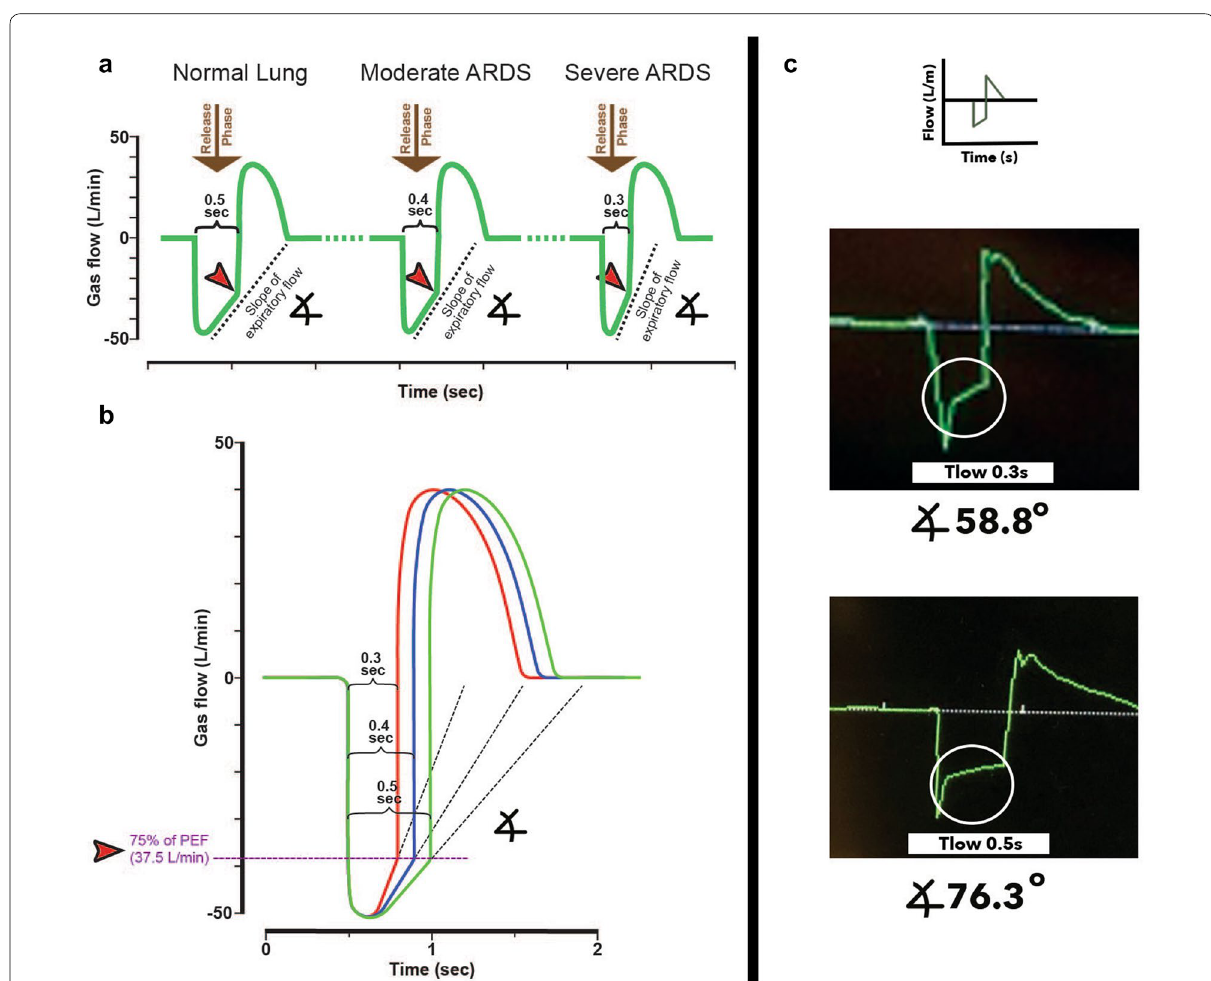
Fig. 6 Personalizing the release phase using the slope of the expiratory flow curve (Slope FE ). The release phase becomes briefer, directed by the Slope FE with lung injury severity. a Normal lung release phase is 0.5 s, with moderate ARDS of 0.4 s and Severe ARDS of 0.3 s, all directed by changes in the Slope FE . b The release phase duration is calculated by expiratory flow terminating ( E FT ) at 75% of the expiratory flow peak ( E FP ) (red arrow head). In this example, the E FP 50 l/min, so flow will be terminated ( E FT ) at 37.5 l/min ( 50 l/min 75% 37.5 l/min). Although the E FT is always = − − − × = − at 37.5 l/min in our example, the release phase duration varies (0.3, 0.4, 0.5 s) due to changes in the Slope FE ( a , b ). We did not directly measure the slope of the expiratory flow curve, but by terminating expiration at 75% of the E FT , changes in the slope change the expiratory duration ( a , b ). Thus, the release phase is both personalized and adaptive as the patient’s lungs become better or worse using the TCAV method. c Expiratory flow/ time graphics on a ventilator monitor from a brain‑dead organ donor meeting Berlin criteria for severe ARDS. The release phase was set using the equation: E FP 75% E FT . The Slope FE when TCAV was initially applied was 58.8°, resulting in a release phase of 0.3 s. Twenty‑four hours on TCAV and × = the Slope FE increased to 76.3°, resulting in a release phase of 0.5 s. The spike in the expiratory flow curve is an artifact due to compression of gas in the ventilator